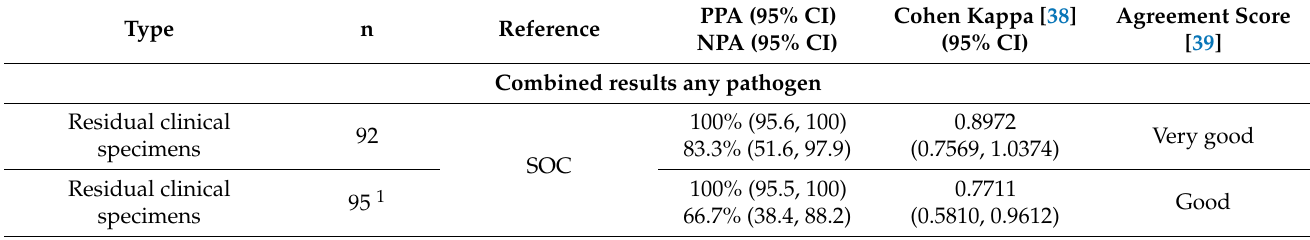
Table 4. Accuracy of the Xpert ® Xpress CoV-2/Flu/RSV plus test compared to qualitative reference results. Positive agreement (PPA), negative agreement (NPA) and agreement are shown, including 95 percent confidence intervals (95% CI). Clinically relevant specimens refer to both residual clinical specimens and reference materials. AccuPlex refers to the AccuPlex SARS-CoV-2, Flu A, Flu B, RSV positive reference